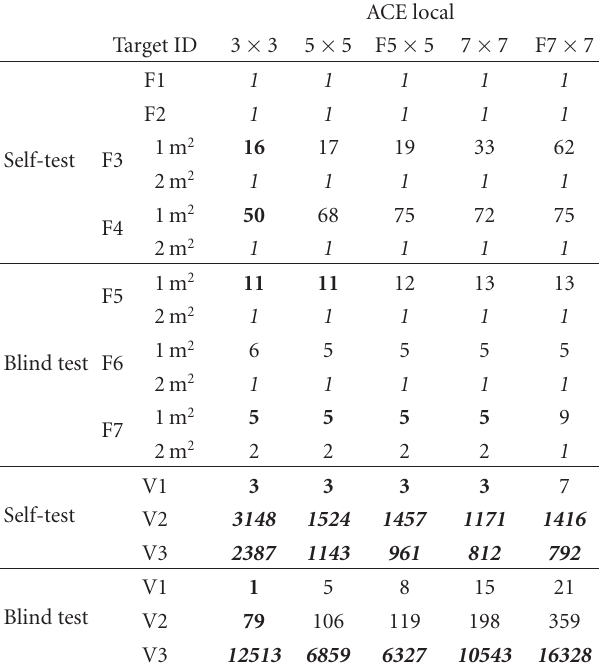
Table 2: Results of global methods.